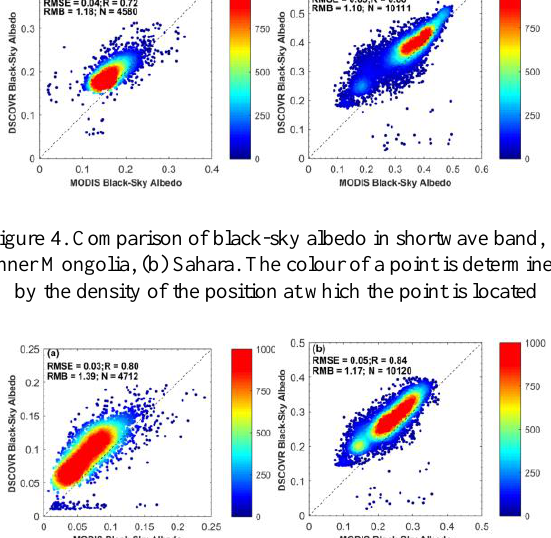
Figure 3. Comparison of black-sky albedo (BSA) in visible band, (a) DSCOVR/EPIC albedo in Inner Mongolia, (b)